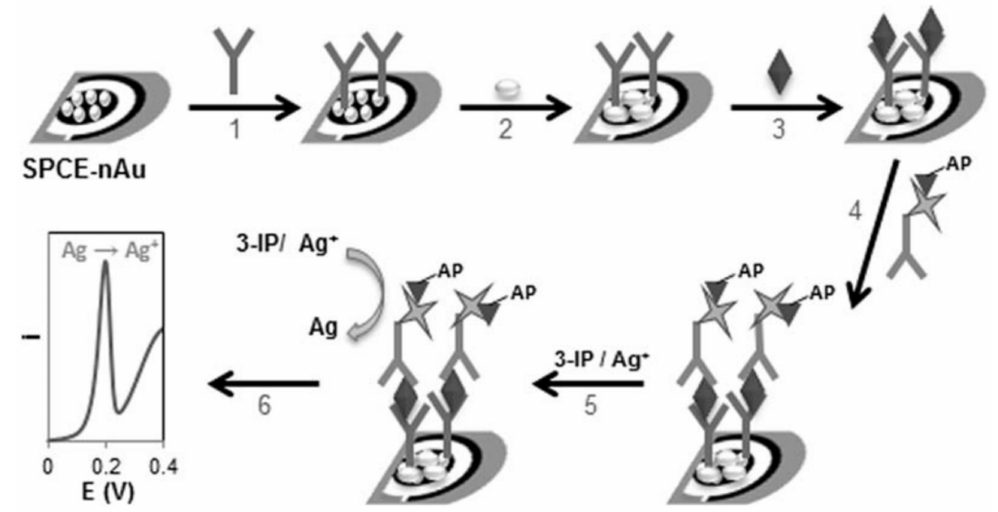
Figure 2. Schematic representation of the construction of the sensor surface and the immunoassay. (1) Capture antibody immobilization, (2) surface blocking (casein), (3) antigen (standard/sample) addition, (4) detection antibody–S-AP addition, (5) substrate (3-IP) and silver ions addition and (6) voltammetric detection of Ag 0 . Reprinted with permission from [63]. Copyright 2015